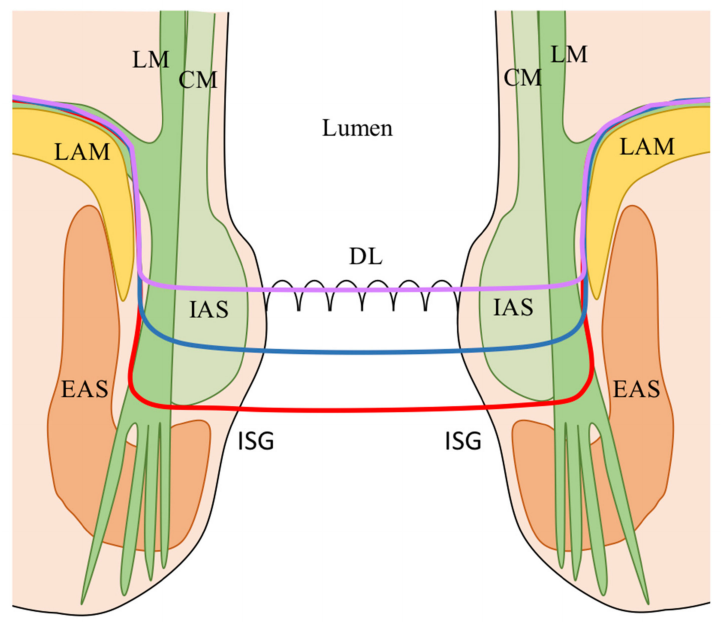
Figure 4. ISR classification according to the extension of dissection [41,42]. Red line: total ISR (complete resection of the IAS at the (ISG); Blue line: subtotal ISR (resection line between the DL and the (ISG); Purple line: partial ISR (resection at the level of the (DL). CM: Circular muscle of the anal canal; DL: Dentate line; EAS: External anal sphincter; IAS: Internal anal sphincter; ISG: Intersphincteric groove; LAM: levator ani muscle; LM: Longitudinal muscle of the anal canal.